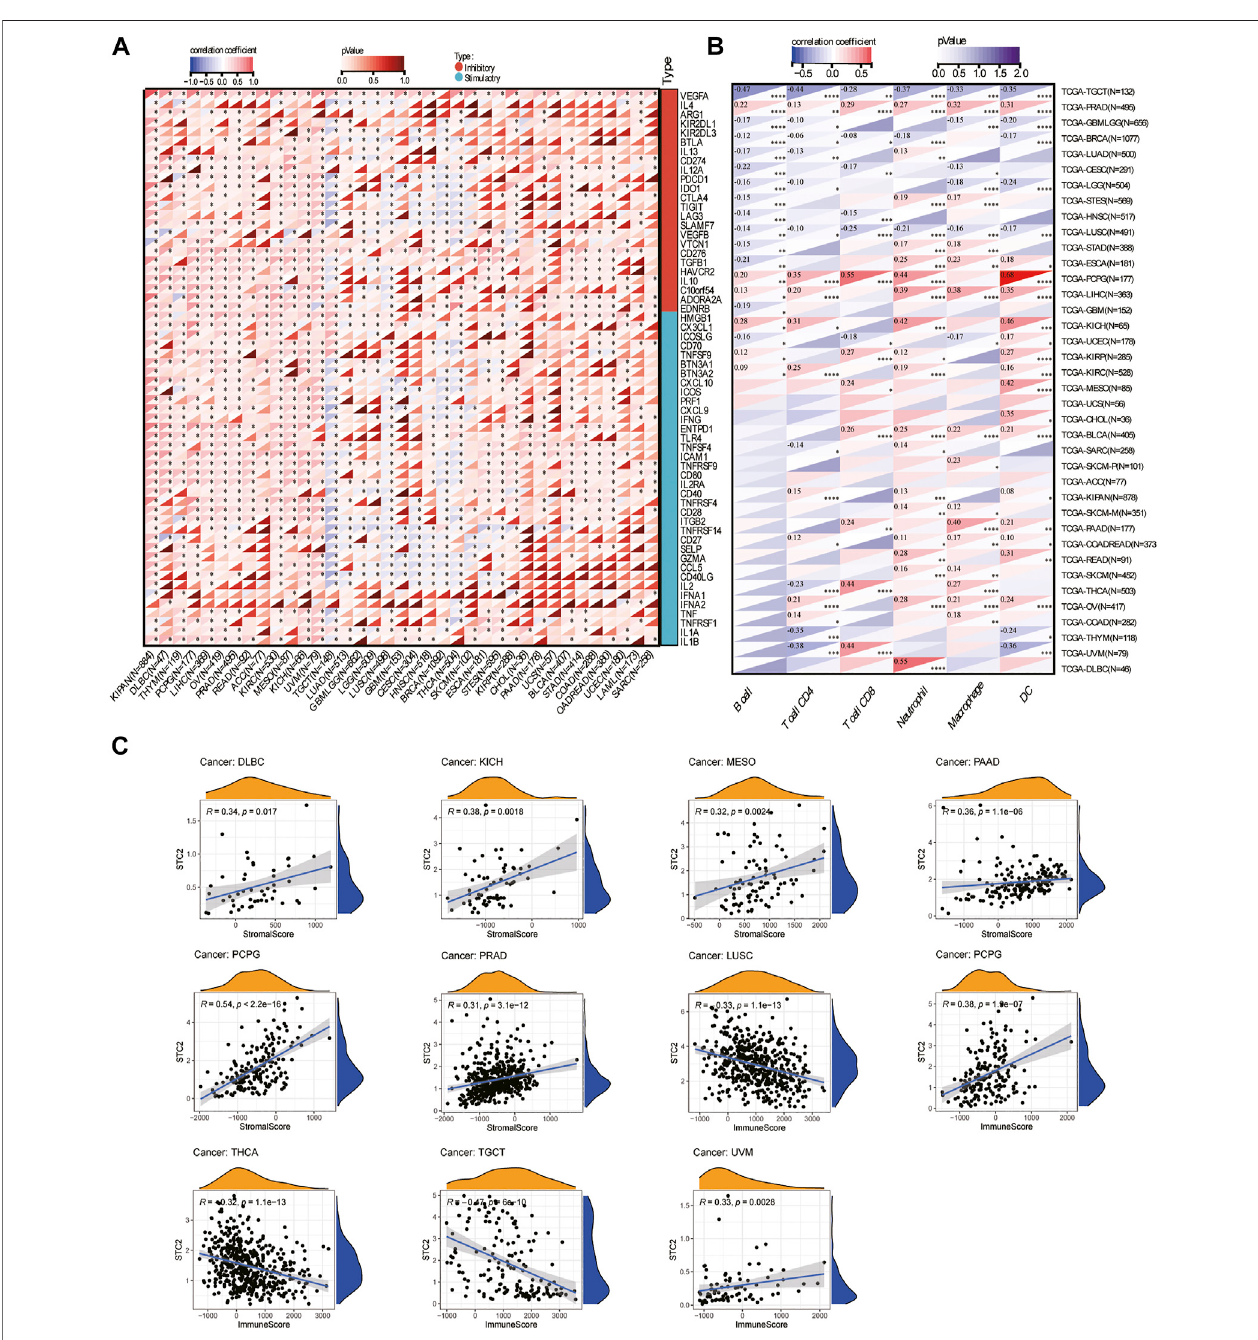
FIGURE 6 | Immunological correlation analysis. (A) The correlation between STC2 expression and immune checkpoint genes. (B) Correlation of STC2 expression withimmunecellin fi ltrationin33cancers.Bluerepresentsnegativecorrelationandredrepresentspositivecorrelation.* p < 0.05;** p < 0.01;*** p < 0.001;**** p < 0.0001. (C) Correlation between STC2 and stromal scores and immune